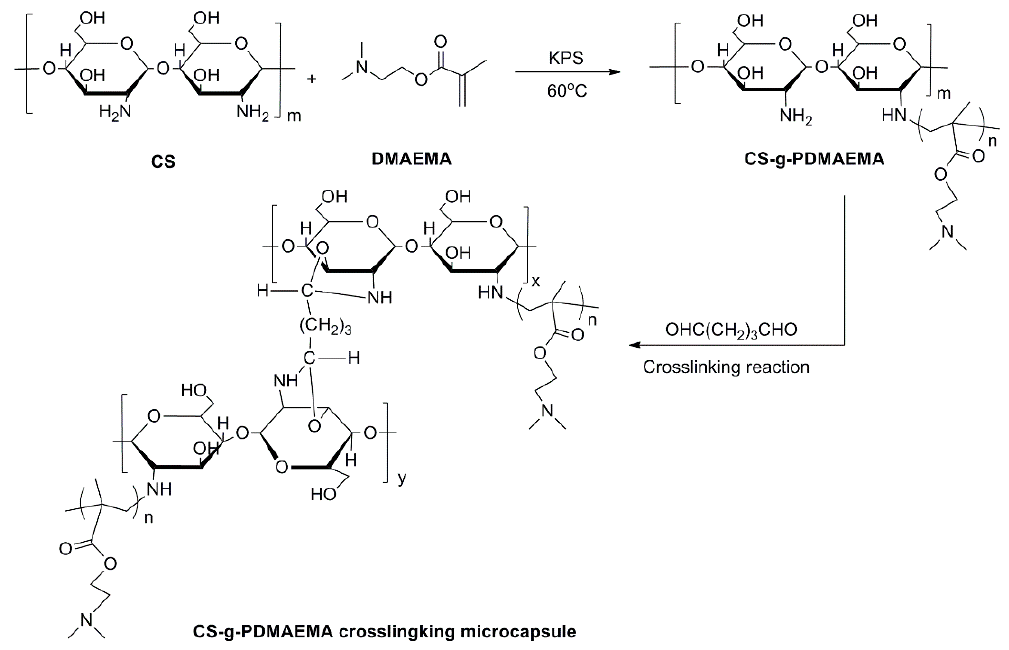
Figure 2. Proposed reaction process for preparation of CS- g -PDMAEMA copolymer and